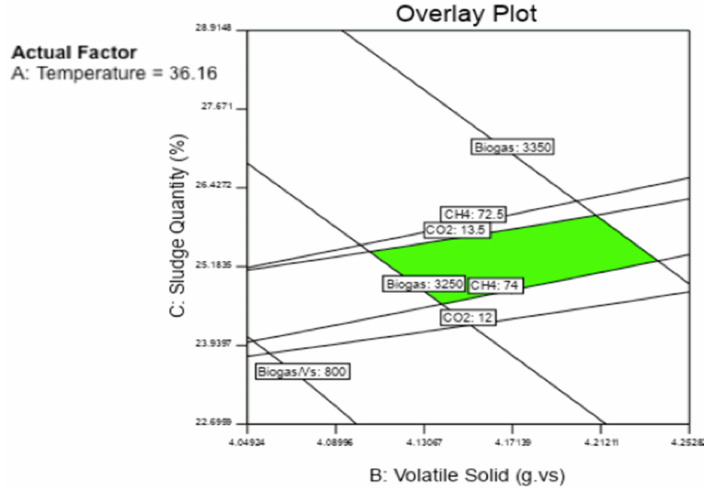
Figure 44. Overlay plot based on the second criterion for date seed.